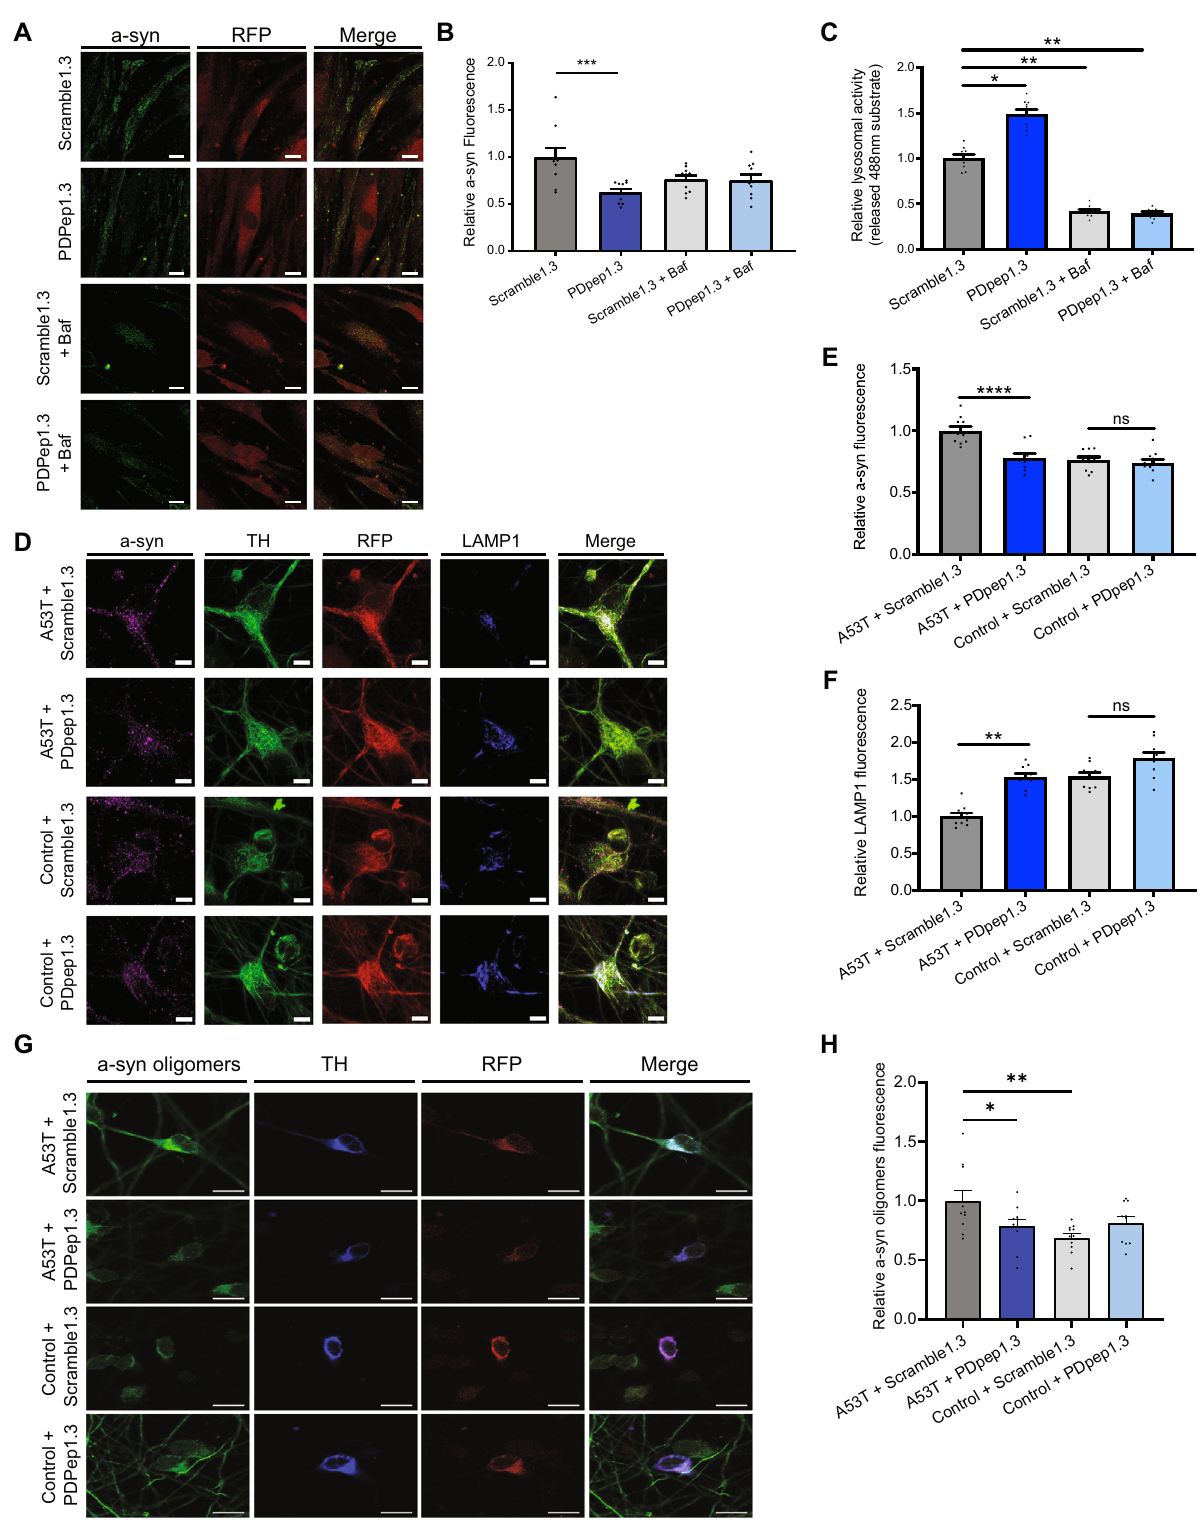
sorting. The cells with positive propidium iodide staining (i.e., dead cells) were fi rst eliminated from the analysis. Genomic DNA preparation and Illumina sample preparation Genomic DNA (gDNA) from peptide expressing cells at different time- points was extracted using QIAamp DNA Blood Mini Kit. PCR ampli fi - cations of peptides from gDNA in parallel with the lentiviral plasmid